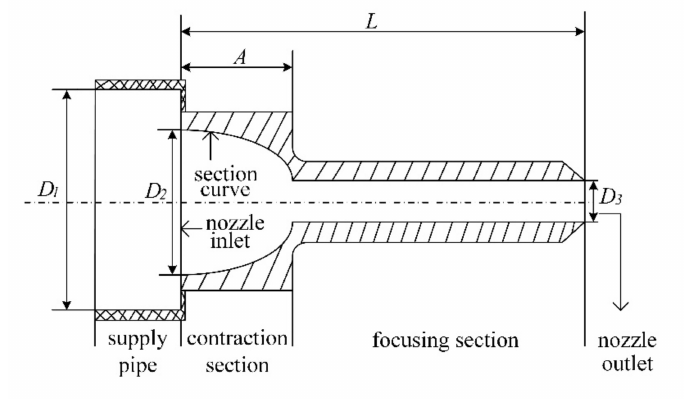
Figure 1. Section geometry of suspension abrasive water jet nozzle and